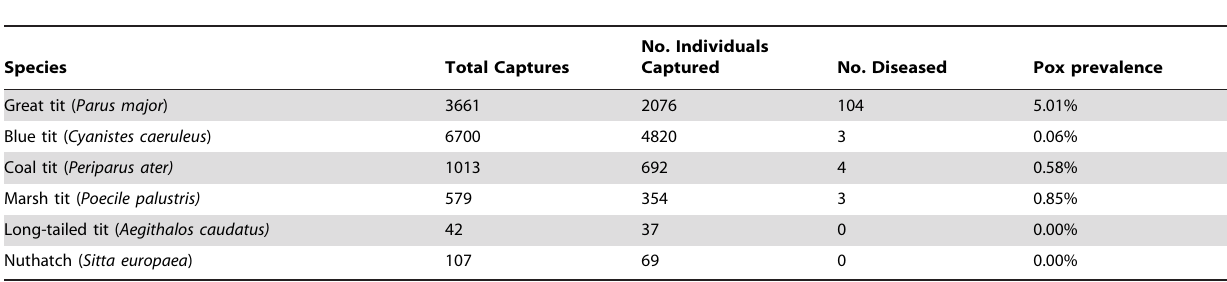
Table 2. Pox prevalence in species within the tit-nuthatch guild captured within Wytham Woods (May 2009–November 2011).